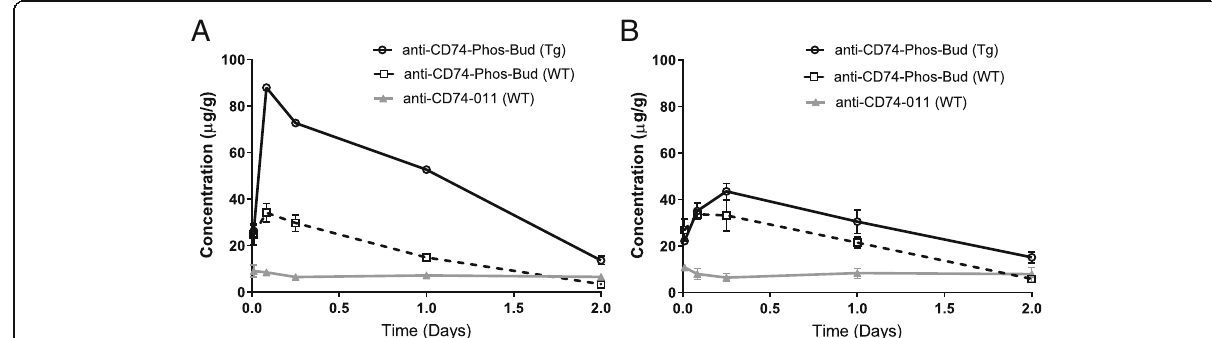
Fig. 6 Tissue distribution of anti-CD74 – 011 and anti-CD74-Phos-Bud. Microgram equivalent per gram concentration of antibodies in spleen ( a ) and liver ( b ) of WT or human CD74 + transgenic (Tg) mice were determined by fluorescence emission-linked assay at multiple time points over 2 days after 5 mg/kg IV dosing. An additional 15 min time-point was collected for anti-CD74-Phos-Bud in Tg mice. Data plotted are mean from two mice per time point. Error bars correspond to the range. Error bars smaller than the symbol are not plotted